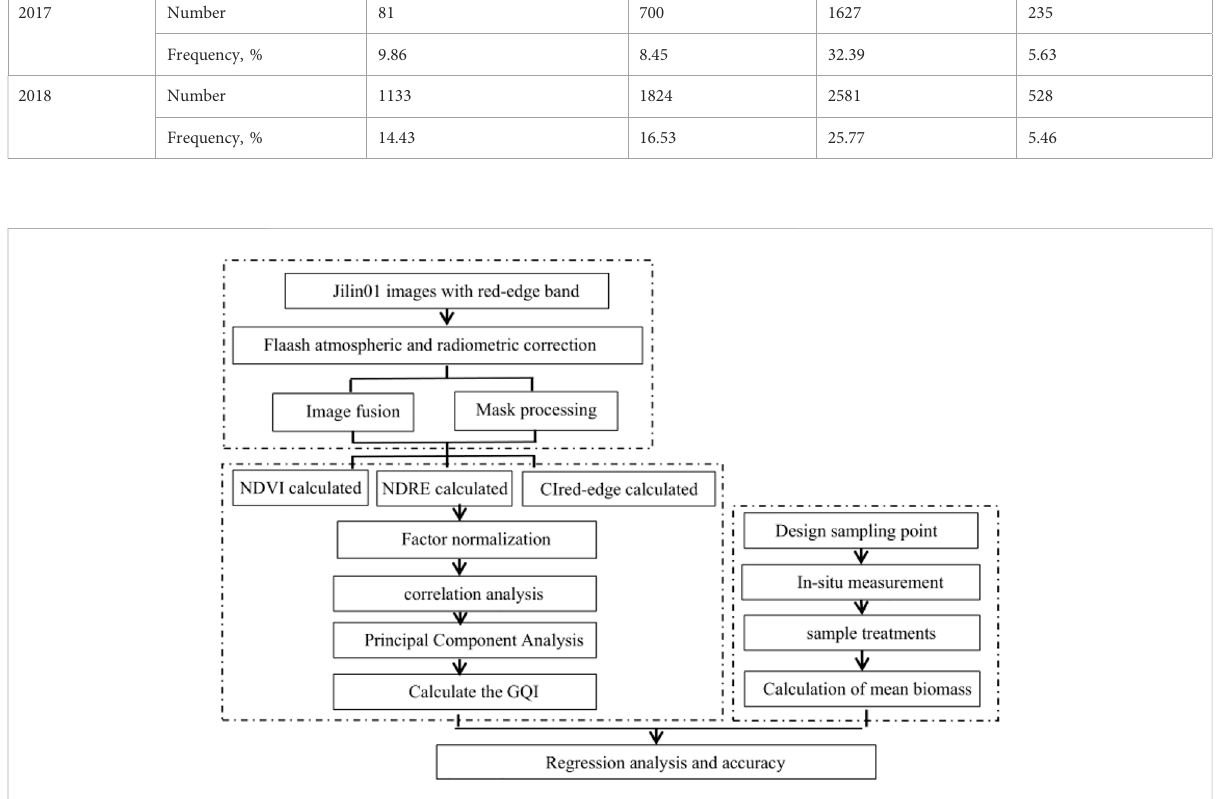
TABLE 1 Habitat types and population statistics of Grusgrus. Habitat type